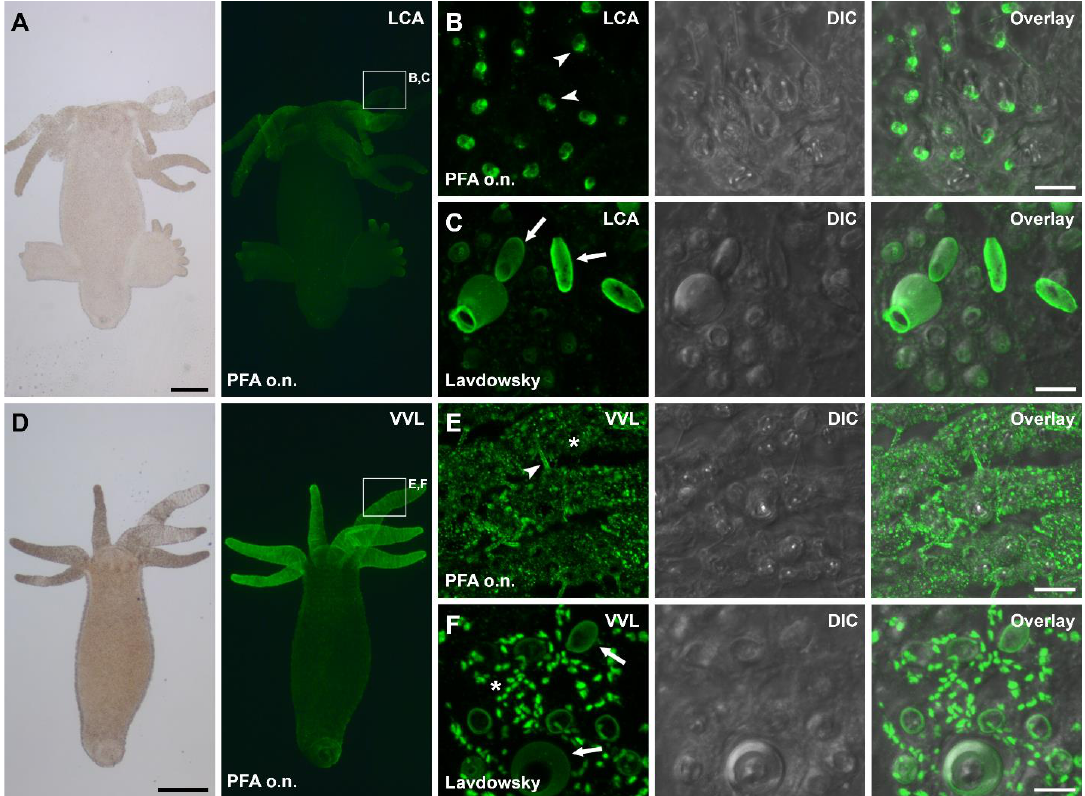
Figure 6. Lectin labeling of Hydra whole-mounts with ( A – C ) LCA and ( D – F ) VVL. ( A – C) LCA labeling of a ( A ) whole-mount individual. Detailed view of stained structures in the tentacles, showing ( B ) cnidocil base staining and ( C ) nematocyst staining, fixed with PFA overnight or Lavdwosky for 4 h, respectively. ( D – F ) VVL labeling of a ( D ) whole-mount individual. Detailed view of stained structures in the tentacles, showing ( E ) cnidocil, nematocytes and dot-like structures and ( F ) nematocytes and dot-like structures, fixed with PFA overnight or Lavdwosky for 4 h, respectively. The fixation method used is indicated in the images. Arrowheads highlight the cnidocil base and the cnidocil, arrows indicate the nematocytes capsules and asterisks the dot-like structures. Scale bars: ( A , D ) 500 µ m; ( B , C , E , F ) 10 µ